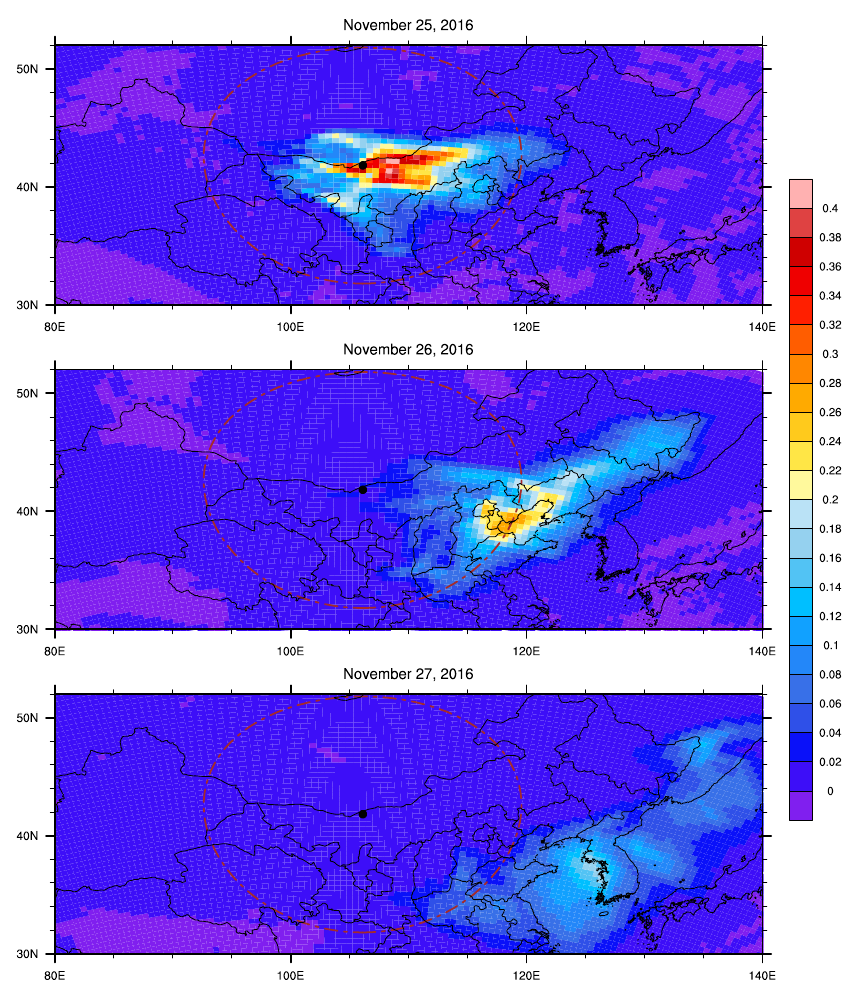
Figure 5. The daily averaged normalized model error covariances of the aerosol optical depths (AODs) on 25, 26, and 27 November 2016 directly estimated from the ensemble perturbations. The model error covariances are estimated with respect to the point of largest dust emission flux at 06:00 UTC on 25 November 2016, denoted by the black dot. The data between 30°N – 52°N and 80°E – 140°E are used. The red circle shows the distance to the black dot point of 1000 km. Table 1. The statistical results of the simulated aerosol optical depths (AODs) over 25 – 27 November 2016 in the six experiments versus the Himawari-8 observed ones. The statistics, including the mean error (Bias), root-mean-square errors (RMSE), correlation coefficient (R), index of agreement (IOA), and skill score (Skill), are calculated between 30°N – 52°N and 80°E – 140°E. There are 17,650 pairs of simulated and observed AODs used to calculate the metrics. The number in bold indicates the best model result. Experiment Bias RMSE